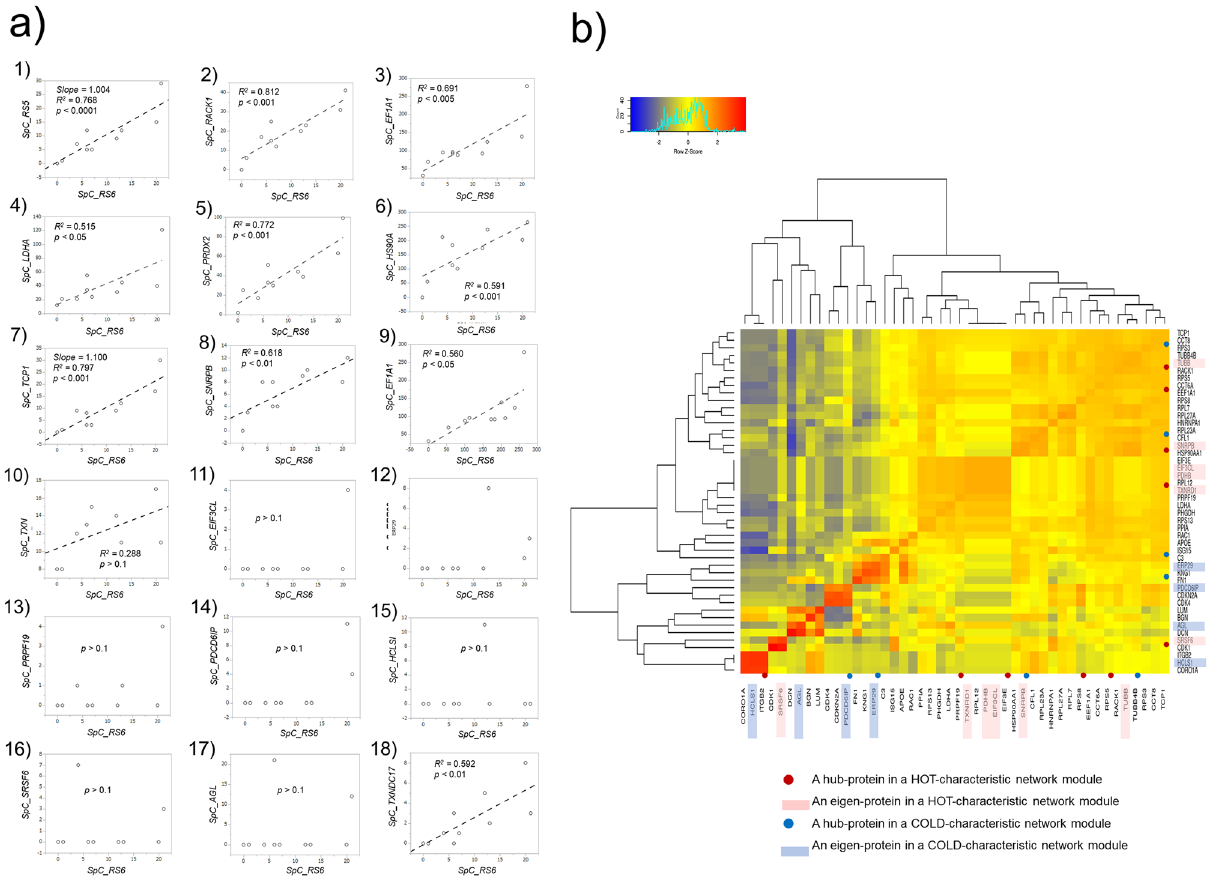
Figure 4. Correlations of representative proteins expressed among all the modules identified for the HOT and COLD traits. ( a ) Spectral count-based semi-quantitative correlations found for eigen- (and/or hub) and other key proteins versus the ribosomal protein S6 (RPS6/RS6), which marks cancer cell growth and proliferation. ( b ) Multivariate correlation analysis (MVA) for the spectral counting-based expression of 46 eigen- (and/or hub-) proteins and other key proteins. Module ID (color) Highly inhibited master regulator ( z